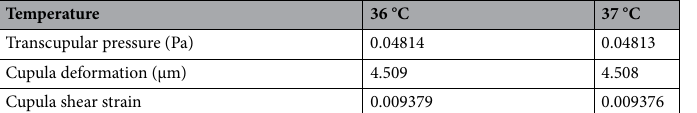
Table 2. The maximal transcupular pressure, cupula deformation, and cupula shear strain under condition of 36 °C and 37 °C respectively. These numerical results ignore the effect of temperature change on the cupula’s elastic